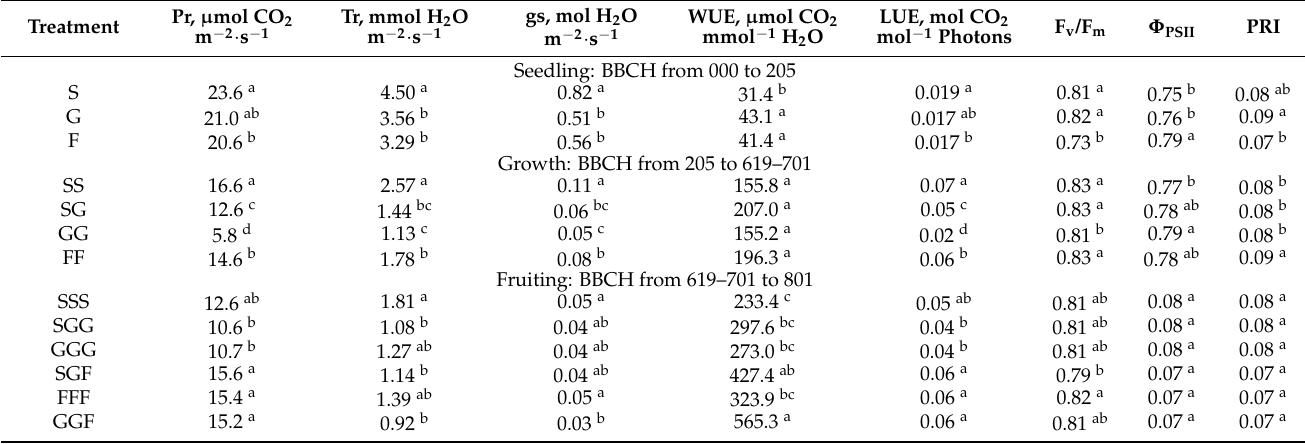
Table 2. Photosynthetic response of tomato subjected to different light spectrum during growth stages*. Different letters indicate statistically significant differences between means according to Fisher’s test at the confidence level p = 0.05. S, G and F—lighting spectrum, selected for “seedling”, “growth” and “fruiting” stages, respectively, and alternated in seedling (S, G, F), biomass growth (SS, SG, GG, FF) and fruiting (SSS, SGG, GGG, GGF, FFF, SGF) tomato growth stages.